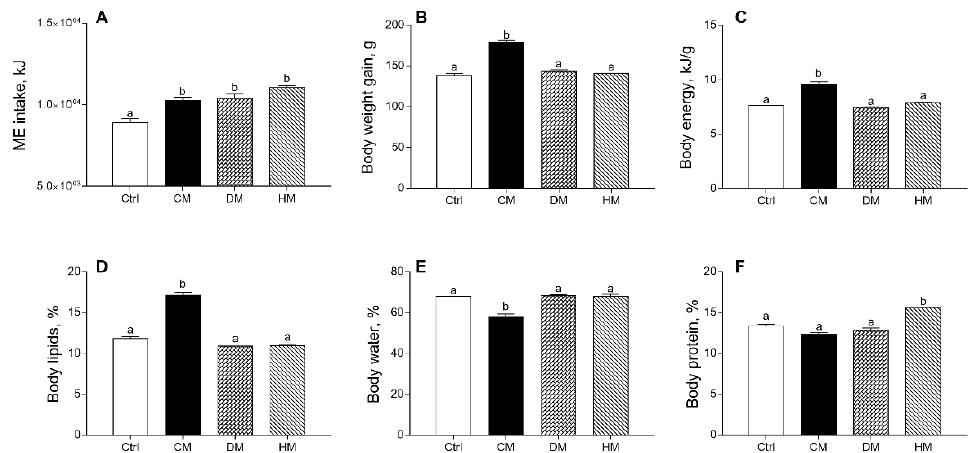
Figure 1. Cow milk (CM), donkey milk (DM) or human milk (HM) diet supplementation influences body weight gain and composition in rats. Metabolizable energy intake (ME) ( A ), body weight gain ( B ) during the study period (4 weeks), body energy ( C ), lipids ( D ), water ( E ) and protein ( F ) were reported. Data were expressed as the means ± SEM n = 7 animals/group. Different letters (a,b) on top of the bars indicate statistically significant differences ( p < 0.05) among groups.